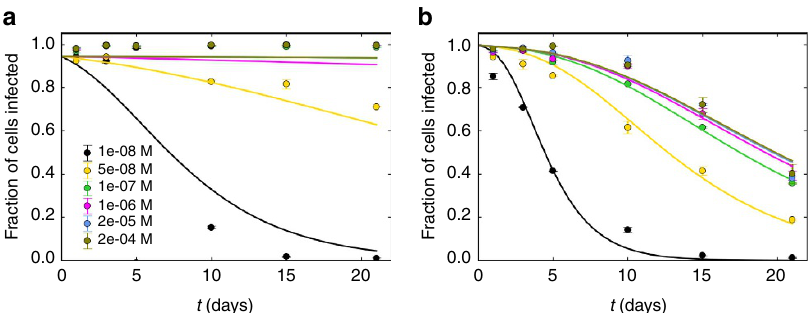
Figure 2 | Maintained Ad5 infectivity versus time in PEG8000 solutions. ( a , b ) Fraction of cells infected versus storage time for Ad5 stored in the presence of different concentrations of PEG at RT ( a ) and at 37 (cid:2) C ( b ). Both panels share the same legend. The curves are fits to the expected infectivity given an exponential decay of viable Ad5 particles with time. The experiments were performed in duplicate. Error bars represent the